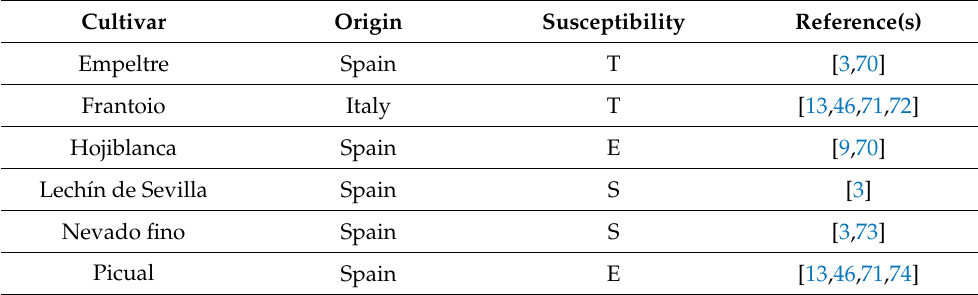
Table 2. Classification of the selected olive cultivars according to their susceptibility to Verticillium wilt of olive caused by the defoliating pathotype of Verticillium dahliae